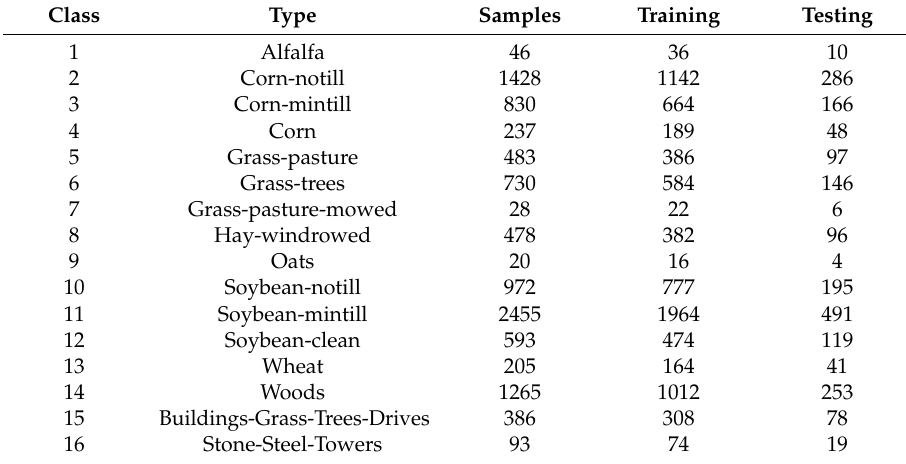
Table 1. Classes and number of test and training samples for Indian Pines (corresponding to Five-Fold cross-validation